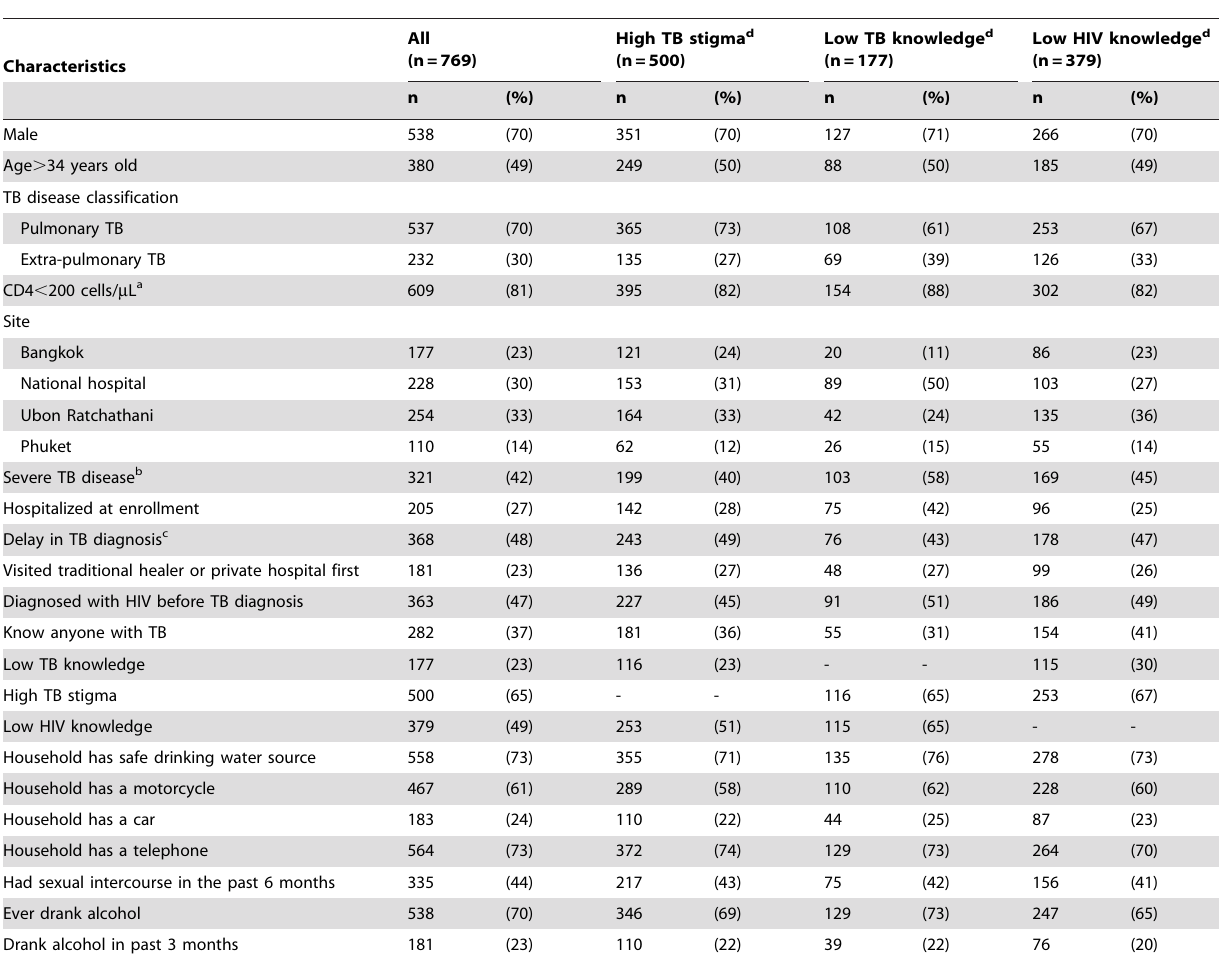
Table 2. Patient characteristics stratified by TB stigma, TB knowledge, and HIV knowledge.